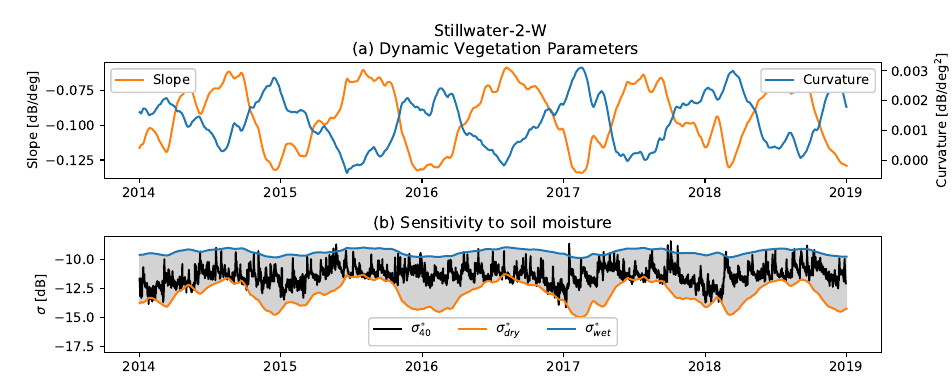
Figure 1. Five years of ASCAT data at Stillwater, Oklahoma (36.1 ◦ N 97.1 ◦ W), to illustrate the estimated variations in ( a ) slope and curvature and ( b ) dry and wet references. The difference between the wet and dry reference, ∆ σ ◦ indicated in grey, is a measure of the sensitivity of backscatter ( σ ◦ ) to soil 40